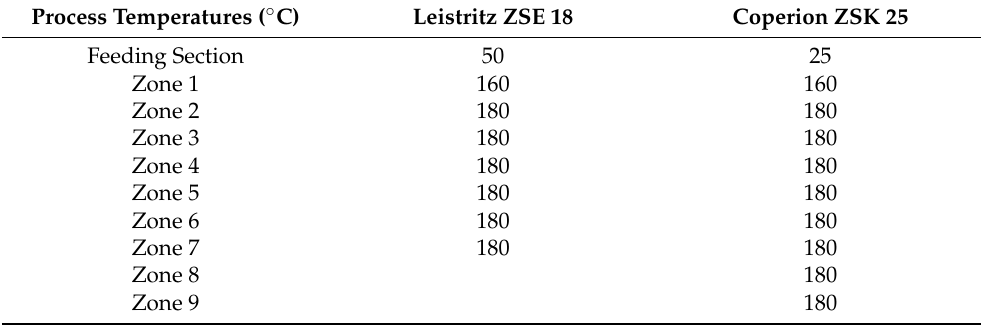
Table 1. Temperatures used in the compounding process in the different twin-screw